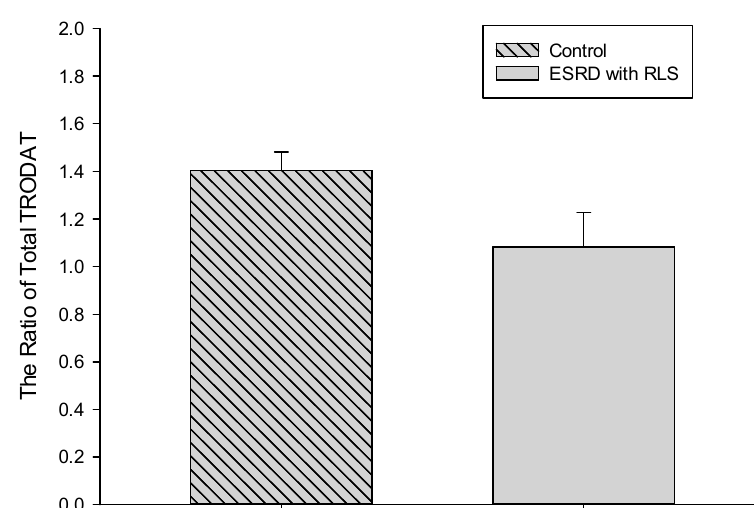
Figure 2. Comparative TRODAT ratio between the control and ESRD with RLS groups.